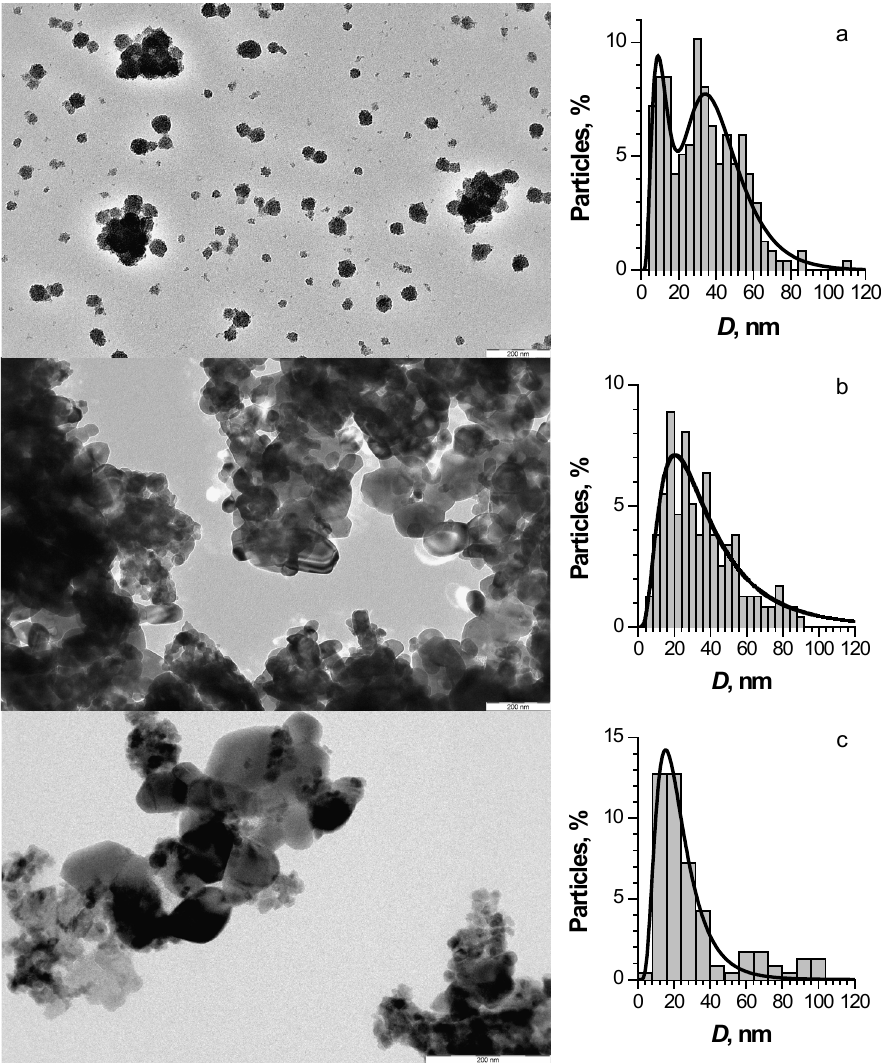
Figure 2. TEM images and particle size distributions of pure ZnO ( a ), ZnO:Cu ( b ), and ZnO:Fe ( c ) nanopowders.